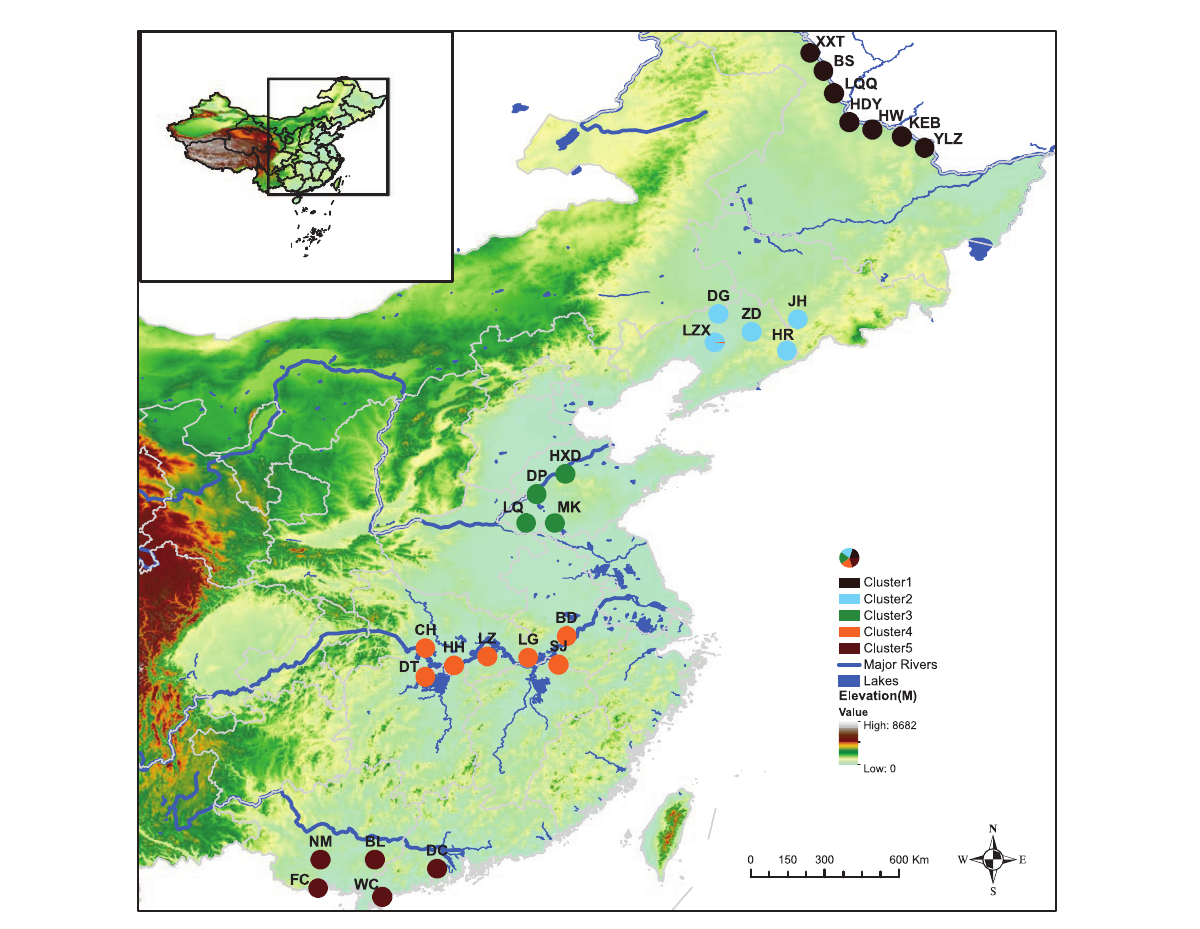
FIGURE2 Geographical distribution of Zizania latifolia samples across the five (I–V) latitudinal regions in China and their respective genetic clusters each denoted by a different color.